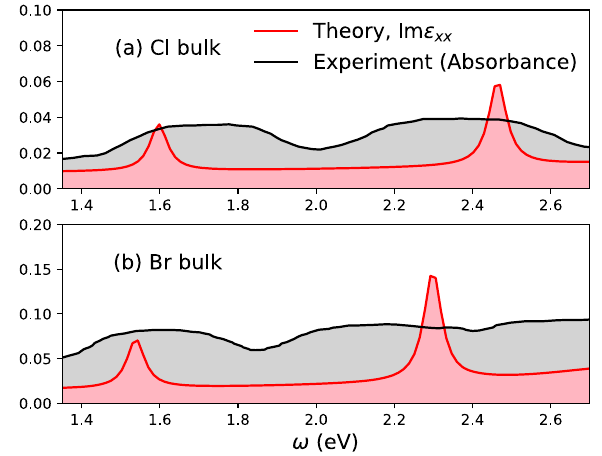
Fig. 2 Robust two-peak deep-lying excitonic structure across bulk and monolayer. The low-energy (0 − 2 eV) part of imaginary part of macroscopic dielectric response Im ϵ xx with the perturbing electric fi eld applied along the (100) direction of the material, for bulk and free-standing monolayers of CrX 3 with ( a ) X = Cl, ( b ) X = Br, ( c ) X = I. Optical broadening of 2 milli-Hartree is used at all energies. The intensities of the peaks are multiplied by some constant factors to bring them to the same scale.